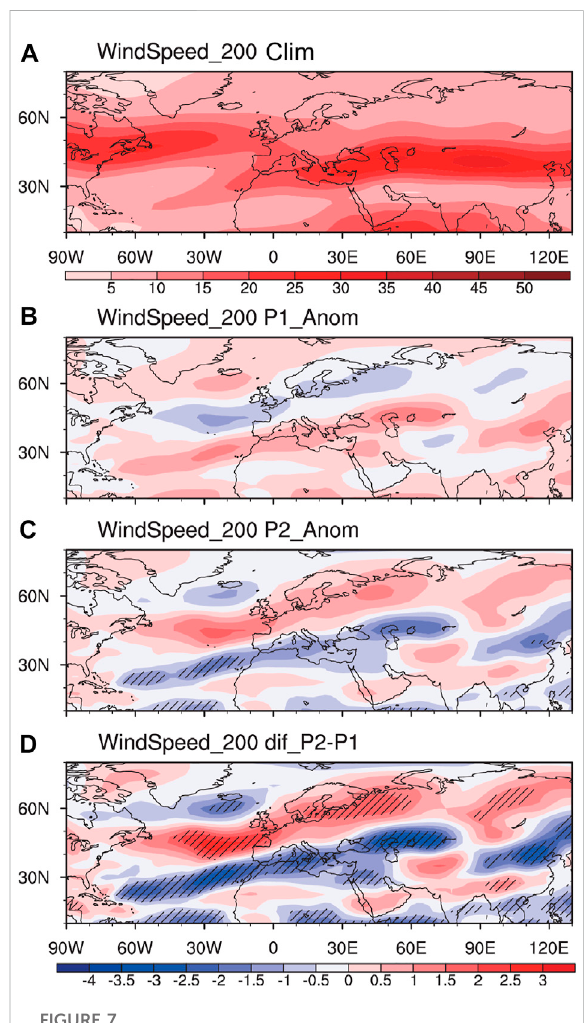
FIGURE 7 Horizontal wind speed at 200 hPa for (A) climatology, (B) difference between P1 and climatology, (C) difference between P2andclimatology,and (D) differencebetweenP2andP1(unit:m/ s, shading indicates signi fi cance at 90% con fi dence level according to the Student ’ s t